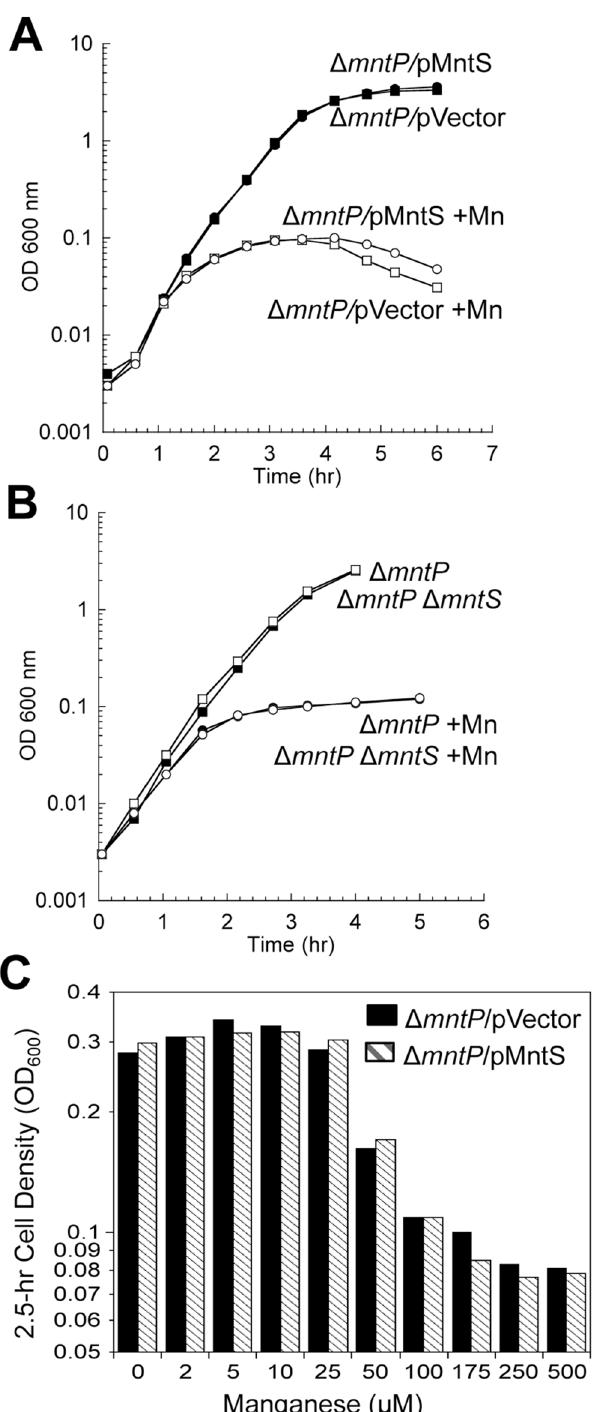
Fig 11. The mntP -null mutation is epistatic to overproduction of MntS with respect to manganese sensitivity. Cells were pre-cultured in aerobic LB medium and then diluted at time zero into fresh LB/ arabinose medium with or without 0.5 mM MnCl 2 . The data are representative of at least three independent experiments. A. Strains were JEM1726 ( Δ mntP /pBAD24) and JEM1727 ( Δ mntP /pLW112, mntS driven by araBAD promoter). B. Strains were MS025 ( Δ mntP ) and JEM1715 ( Δ mntP Δ mntS ). C. Growth density determined after growth with manganese for 2.5 hr. Strains were JEM1726 ( Δ mntP /pBAD24) and JEM1727 ( Δ mntP /pLW112, mntS driven by araBAD